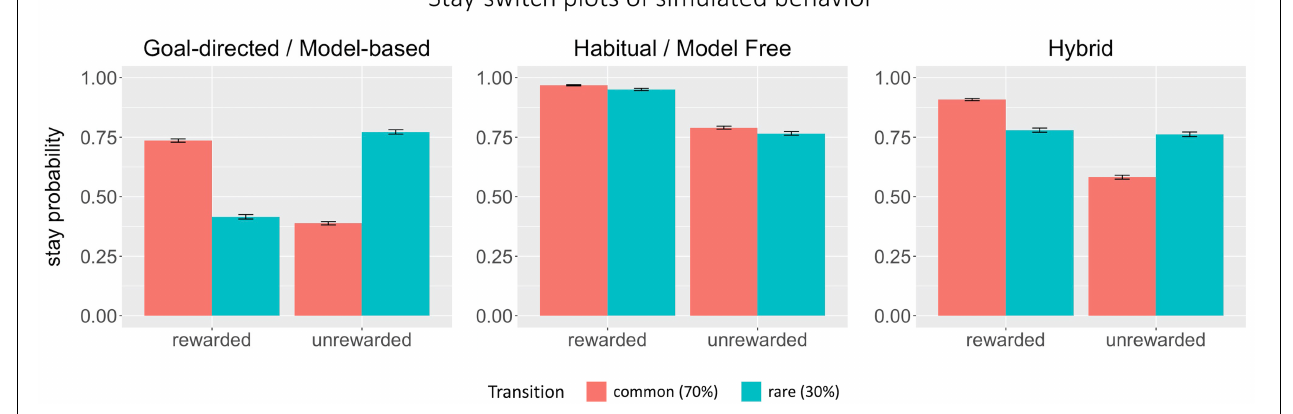
FIGURE 2 | Stay-switch plots of simulated behavior. Graphs depicting purely model-based (goal-directed), purely model-free (habitual), and hybrid behaviors. Purely model-based behavior is predicted by an interaction between reward and transition, whereas purely model-free behavior is predicted solely by reinforcement history. Hybrid behavior represents a mix of model-based and model-free behavior.